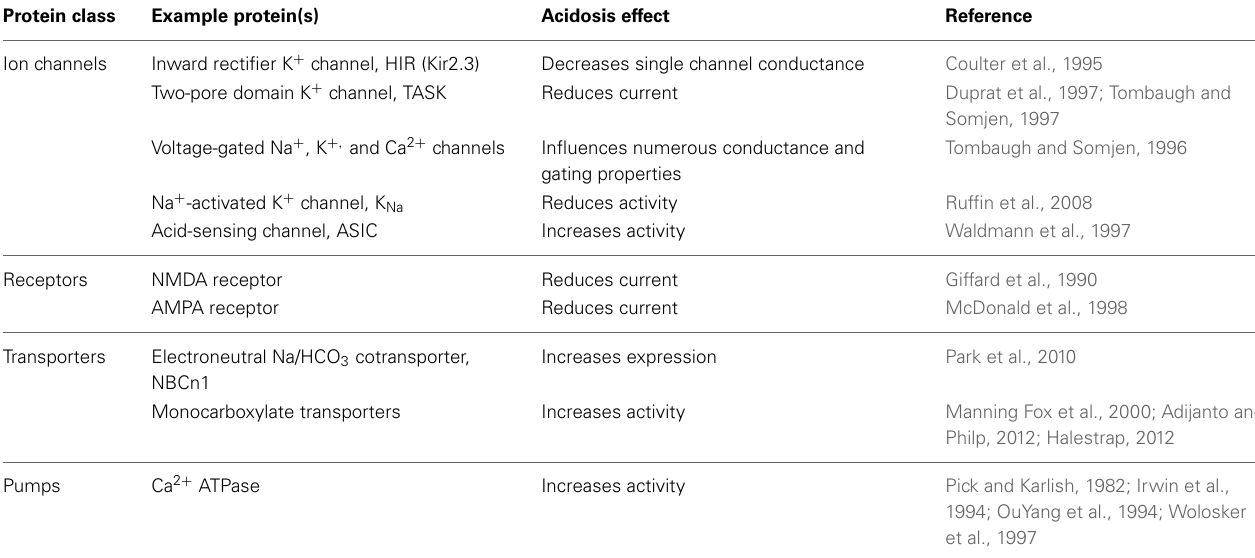
Table 1 | Examples of pH-sensitive membrane proteins expressed in